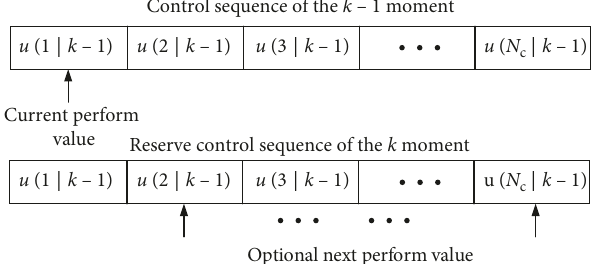
Optional next perform Figure 4: Schematic diagram of predictive control